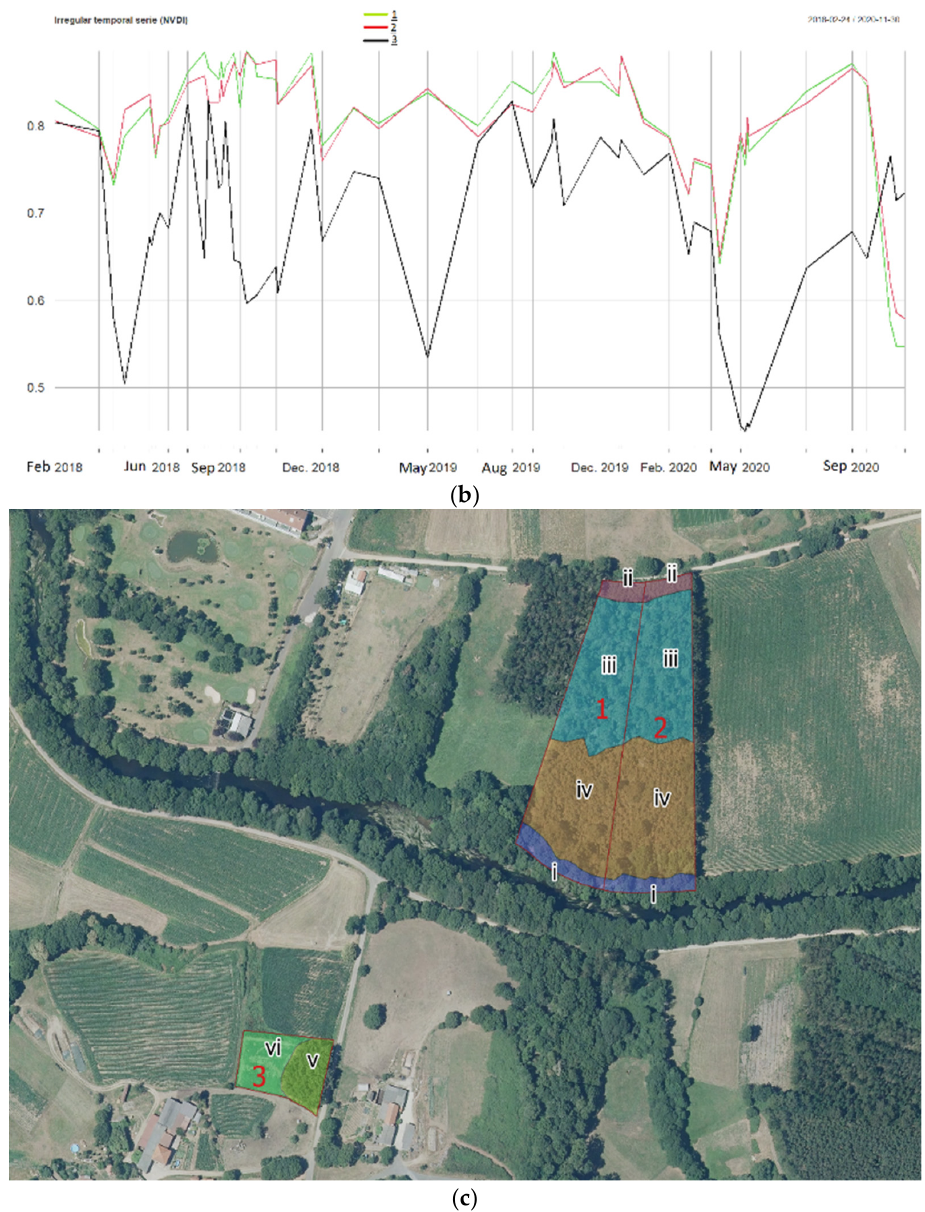
Figure 7. ( a , b ) Temporal variations in NDVI in three plots with different species and states. ( c ) Land uses in plot N ◦ 1: (i) Leafy riparian deciduous (0.07 ha). (ii) Leafy deciduous dominated by Q. robur (0.04). (iii) Irregular mass formed by P. pinaster and loose stands of E. globulus (0.44 ha). (iv) Coniferous plantation with loose, isolated stands of E. globulus (0.48 ha). Land uses in plot N ◦ 2: (i) Deciduous broadleaved riparian hardwoods (0.08 ha). (ii) Coniferous plantation with loose and isolated stands of E. globulus (0.48 ha). (iii) Irregular mass consisting of P. pinaster and single stands of E. globulus (0.46 ha). (iv) Deciduous hardwoods dominated by Q. robur (0.04 ha). Land uses in plot N ◦ 3: (v) P. radiata plantation (0.13 ha). (vi) Grassland and cultivation (0.16 The temporal information obtained for each plot allowed the correct overall analysis of the biomass of each plot. The different felled plots were mainly reforested by Pinus and Eucalyptus , although in many plots, other species (mainly deciduous hardwoods, scrub, grasses, etc.) were mixed that were not felled and that had a different evolution over the